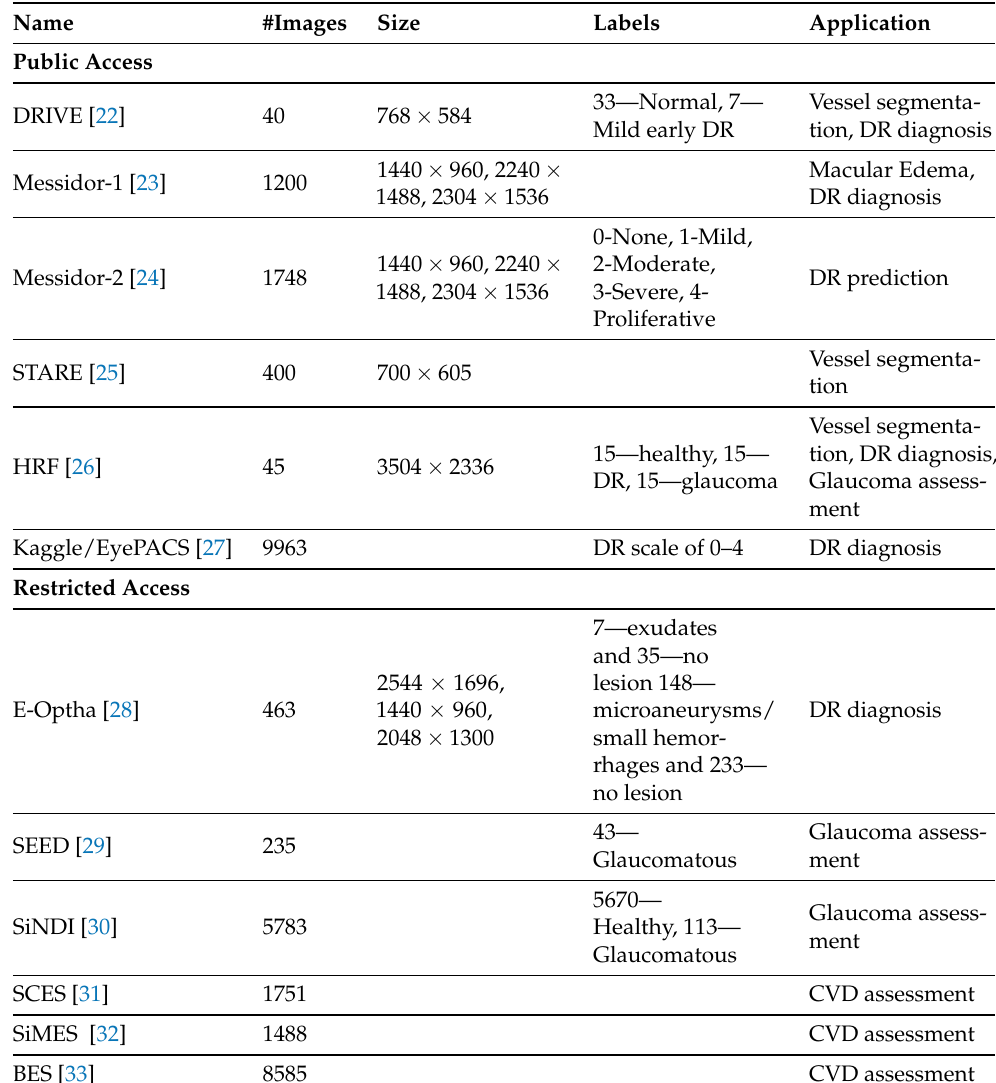
Table 1. Overview of public/restricted access retinal image datasets used in cardiovascular dis- ease